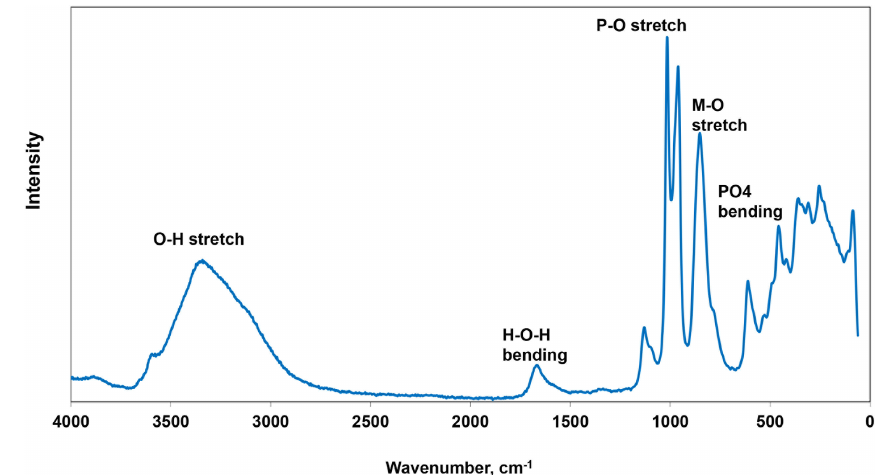
Figure 4. Raman spectrum for pleysteinite.